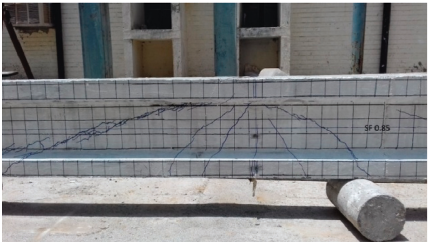
Figure 20: Crack patterns of